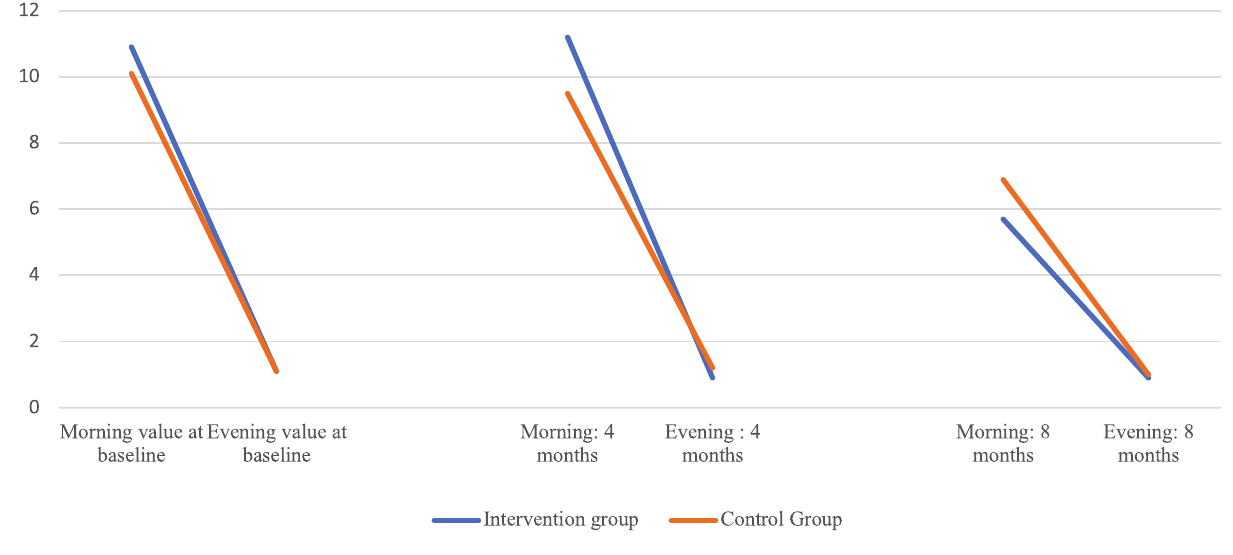
During the whole intervention period (both the autumn and spring) period, 12 girls had low attendance, 17 girls had medium attendance and 18 girls had high attendance ( n = 47). There was no statistical difference in the median evening/morning quotient between low, medium, and high attendance group at 4 months ( p = 0.919) or at 8 months ( p =